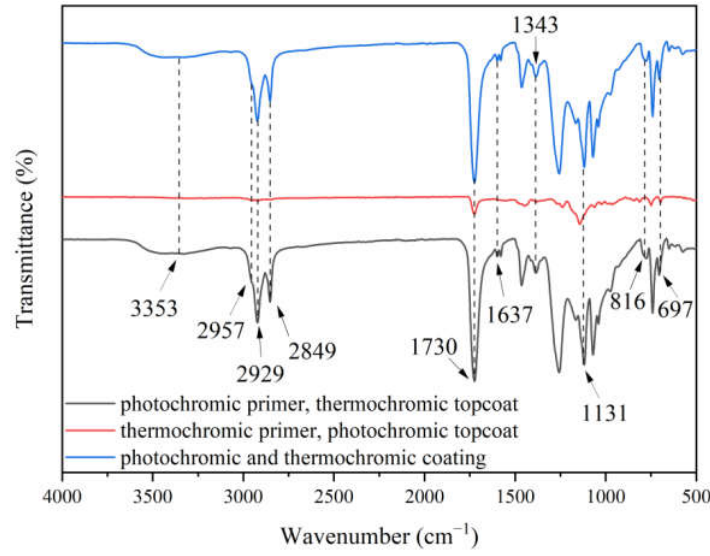
Figure 4. FTIR of the film under different finishing processes.